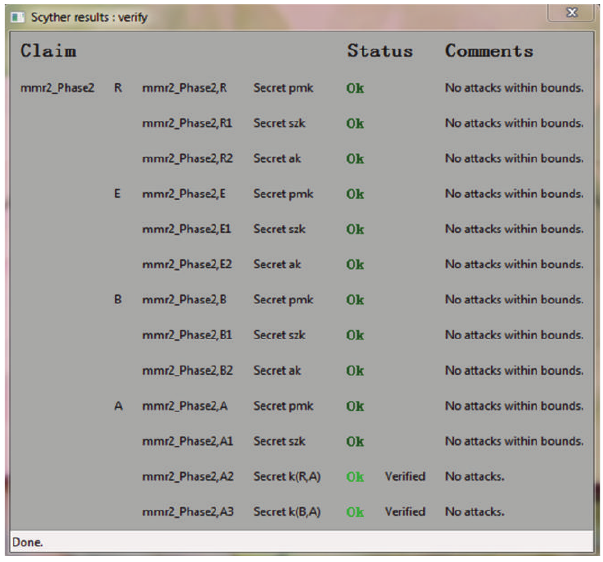
Figure 6: Verification result for Protocol 2-Phase 2, mutual authen- tication.